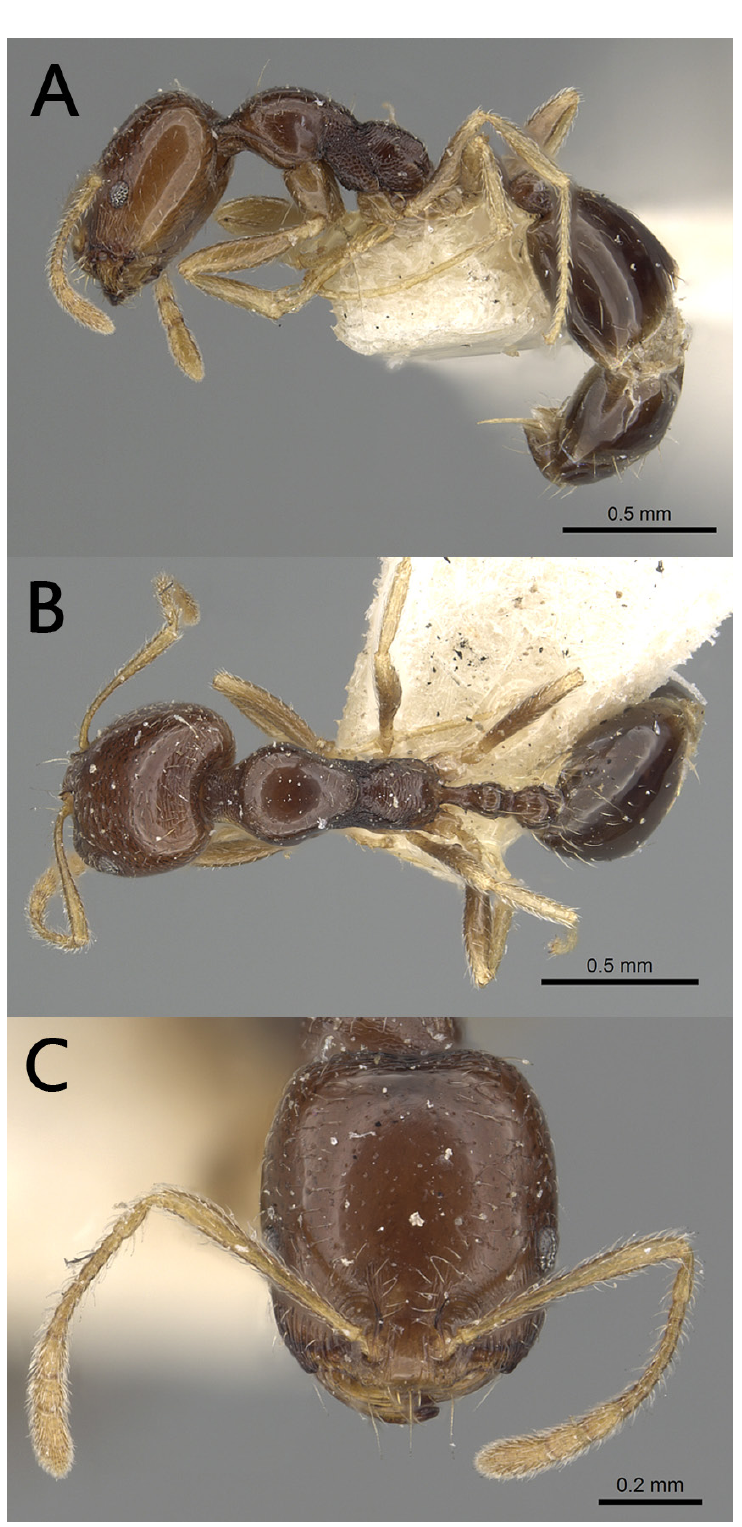
Fig. 10. Trichomyrmex mayri (Forel, 1902), lectotype, worker (CASENT0249904) . A . Body in profile. B . Body in dorsal view. C . Head in full-face view (photos: Shannon